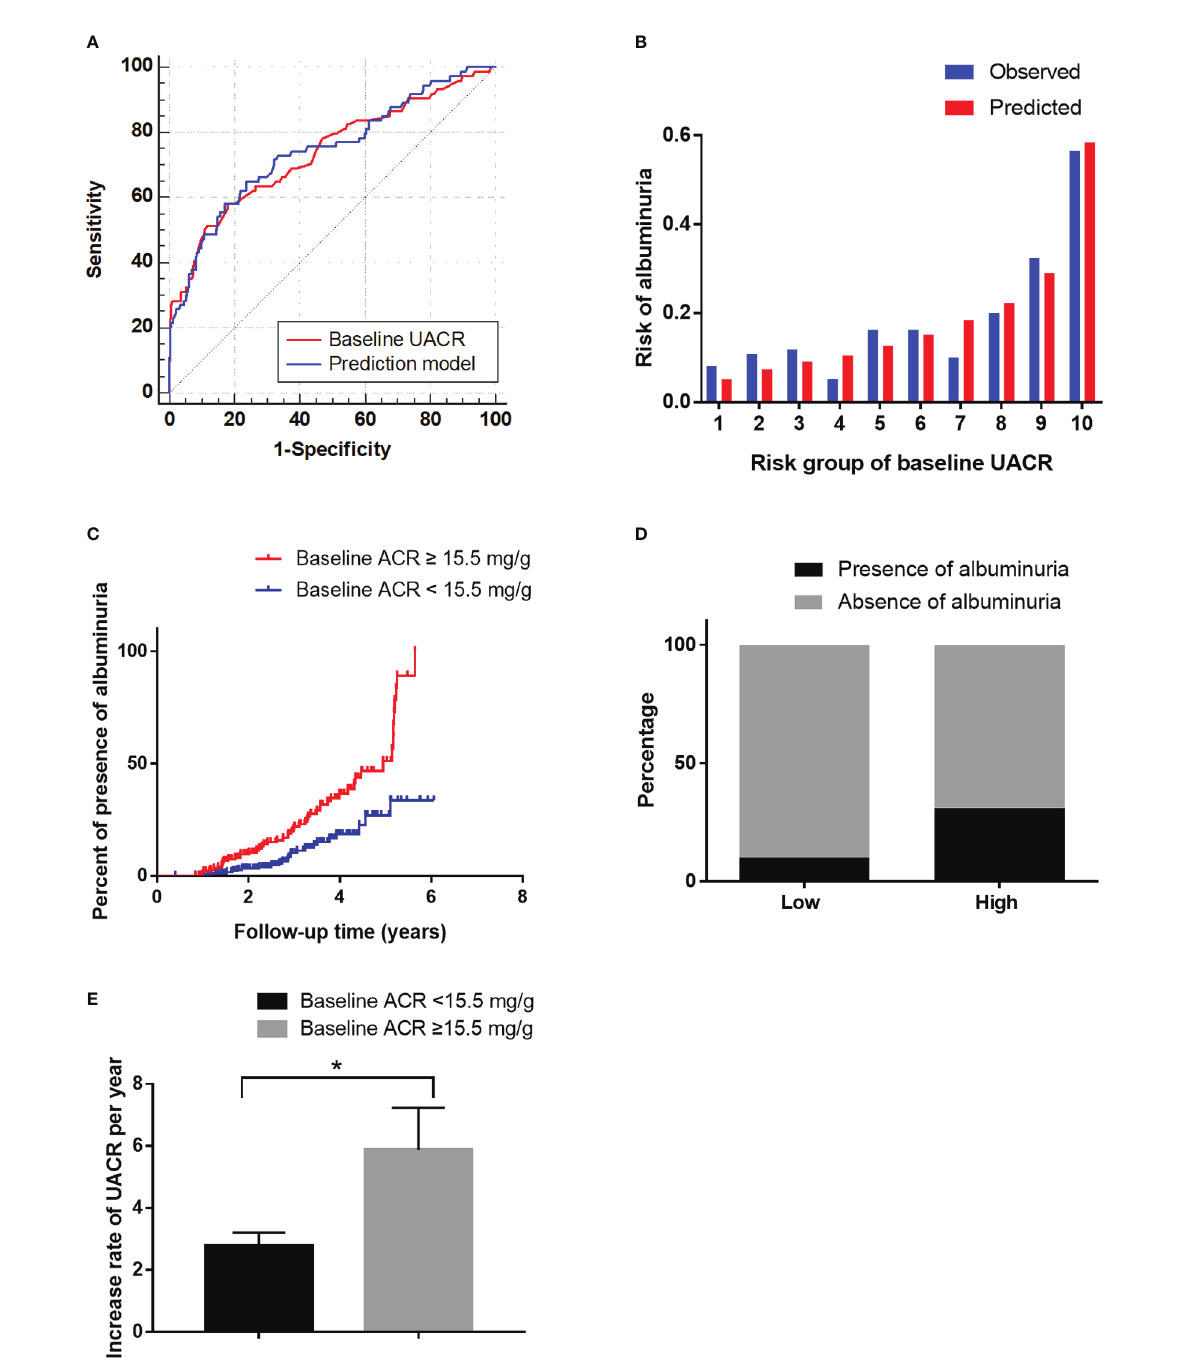
FIGURE 3 The performance of the baseline UACR in predicting albuminuria in the development cohort. (A) : Receiver operating characteristic curve for the baseline UACR and the prediction models. The area under the curve (AUC) and its 95% CI were 0.74 (0.67 – 0.81) for the baseline UACR and 0.74 (0.68-0.81) for the prediction model. The discriminative power of baseline UACR vs the prediction model (P=0.465). (B) : Hosmer-Lemeshow (H-L) test for the calibration of the baseline UACR (P=0.22). (C) : Kaplan-Meier curve of albuminuria end point for the low-risk (UACR < 15.5 mg/g) and high-risk groups (30 > UACR ≥ 15.5 mg/g) according to the cut-off value. The HR (95% CI) was 1.66 (1.31-2.10) (P < 0.001) in the high-risk group. (D) : Prevalence of albuminuria in the low-risk (UACR <15.5 mg/g) and high-risk (30 > UACR ≥ 15.5 mg/g) groups. (E) : The increase rate of UACR per year in the low-risk (UACR < 15.5 mg/g) and high-risk groups (30 > UACR ≥ 15.5 mg/g) according to the cut-off value. * P <